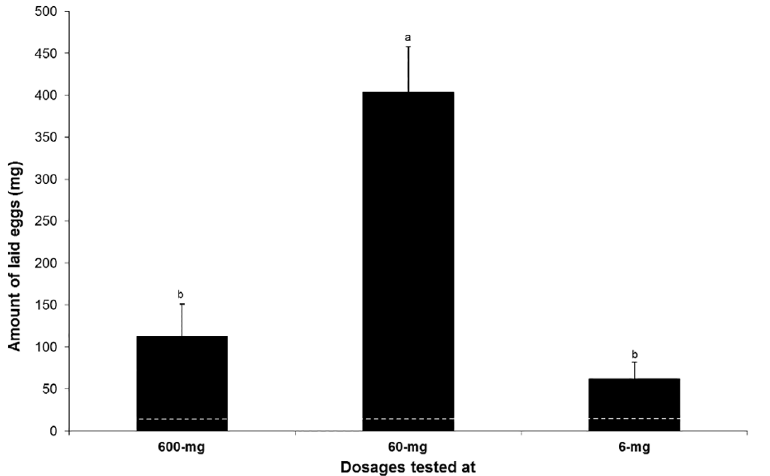
Fig 4. Amount of eggs (Means ± Std. Error) laid by gravid females of primary screwworm flies tested in cages baited with synthetic lures at three dosages of 600 mg, 60 mg and 6 mg. Different letters on top of the bars indicate significantdifferences (ANOVA, followedby LSD, P < 0.05). Dashedlines indicatemean amount of eggs laid from the